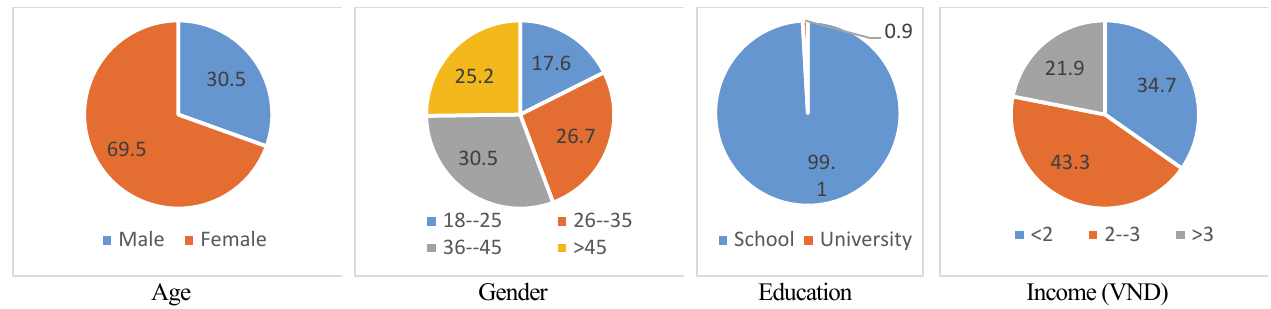
Fig. 2 . The s ample description of survey participants